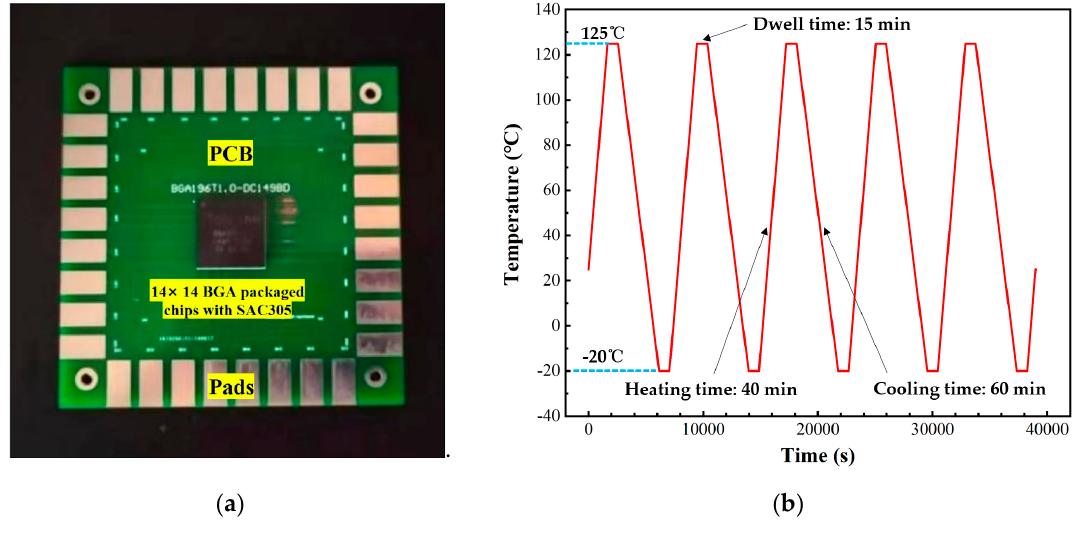
Figure 1. ( a ) PCB test board in thermal cycling test. ( b ) Temperature profile.